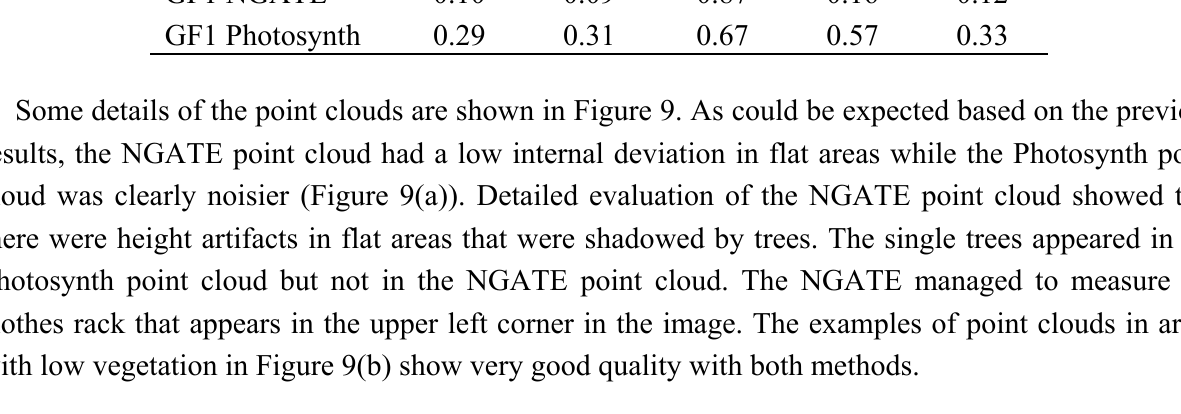
Figure 9. Examples of point clouds: ( a ) Gravel road (shaded representation) and ( b ) low vegetation. Left : GF 1 image; center : NGATE; right :